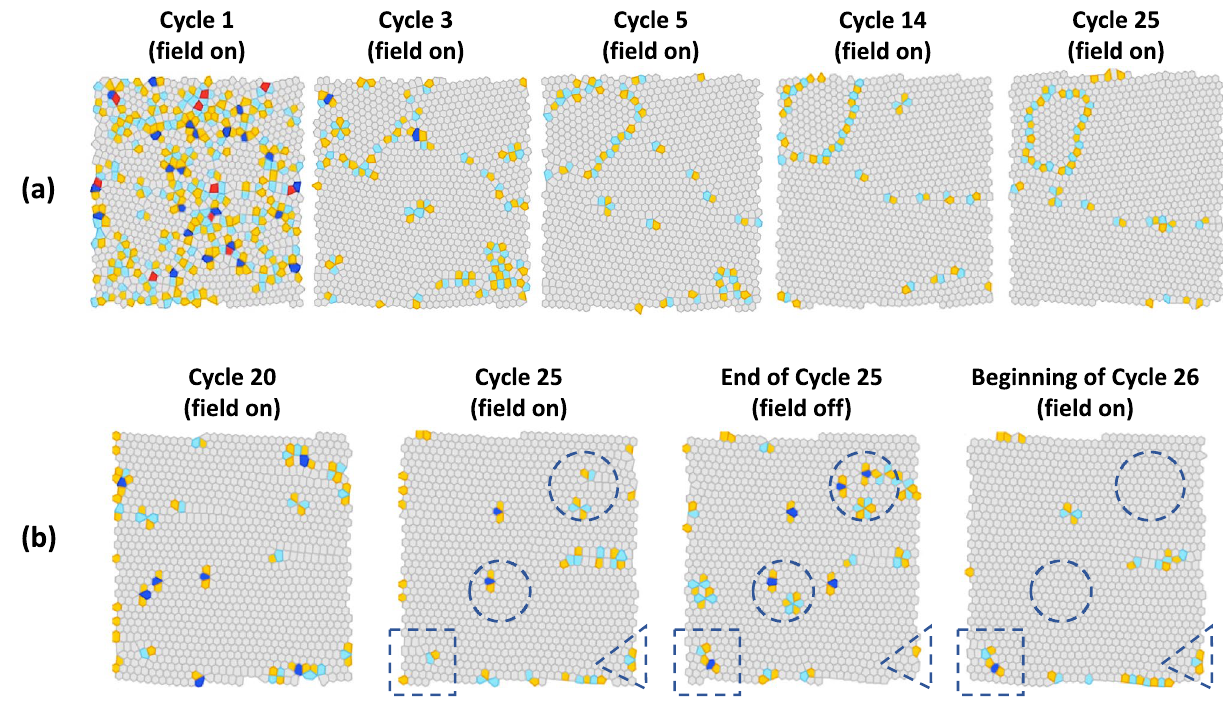
Figure 2. Voronoi analysis of colloidal crystals annealing. ( a ) Voronoi diagrams of experimental CLSM images 0.5 at cycle 1, 4, 5, 14 and 25. ( b ) “On to off” and “off to on” Voronoi under field-on condition with t off /τ 50 = 0.25 that show three types of defects rearrangement: recombination of defect pairs diagrams with t off /τ 50 = (circle), generation of new defects (square), and static defects